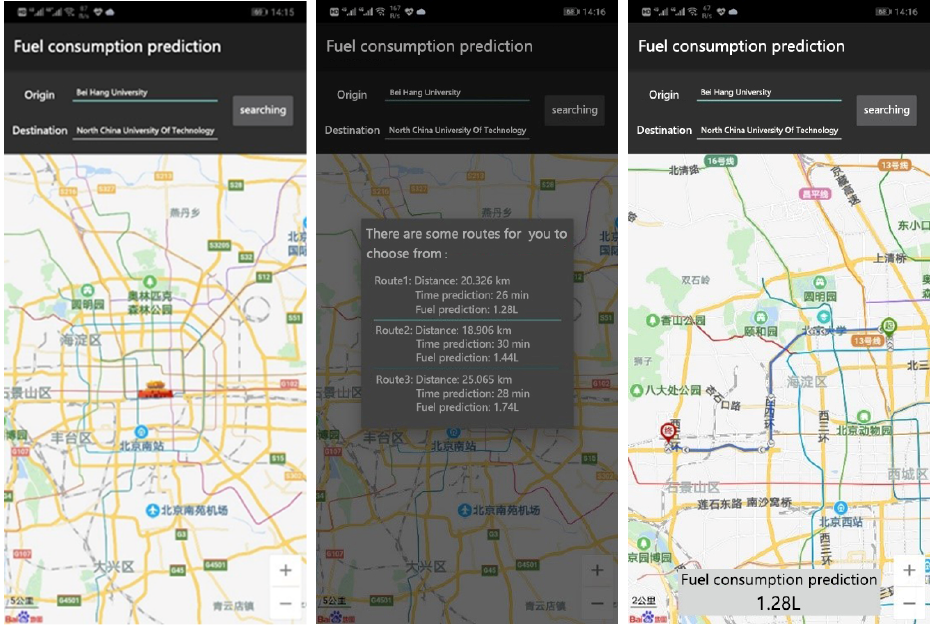
Figure 8. The application interface.